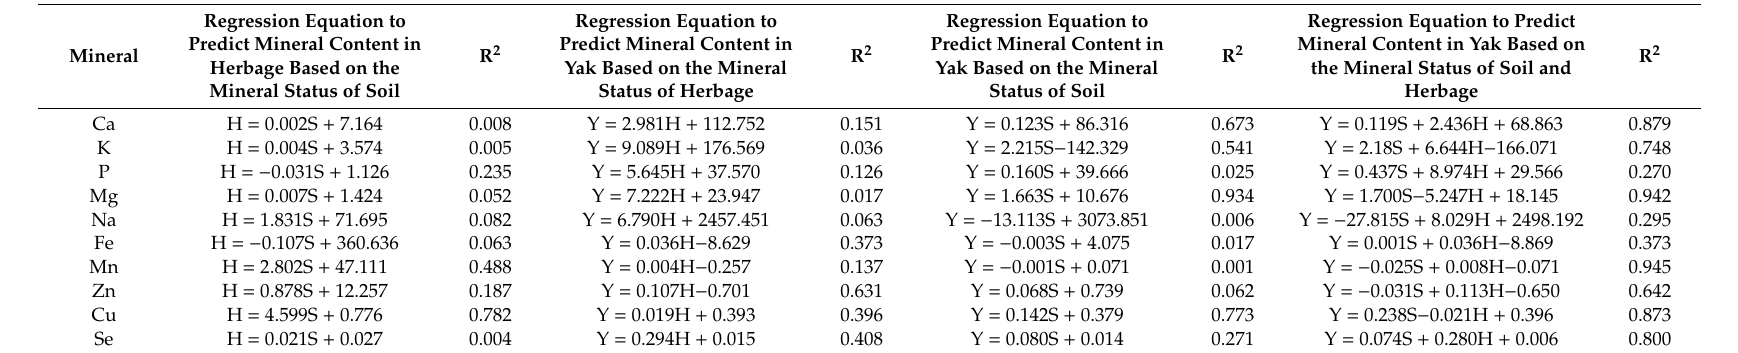
Table 9. Regression equation of the soil − plant − yak continuum in relation to mineral status in